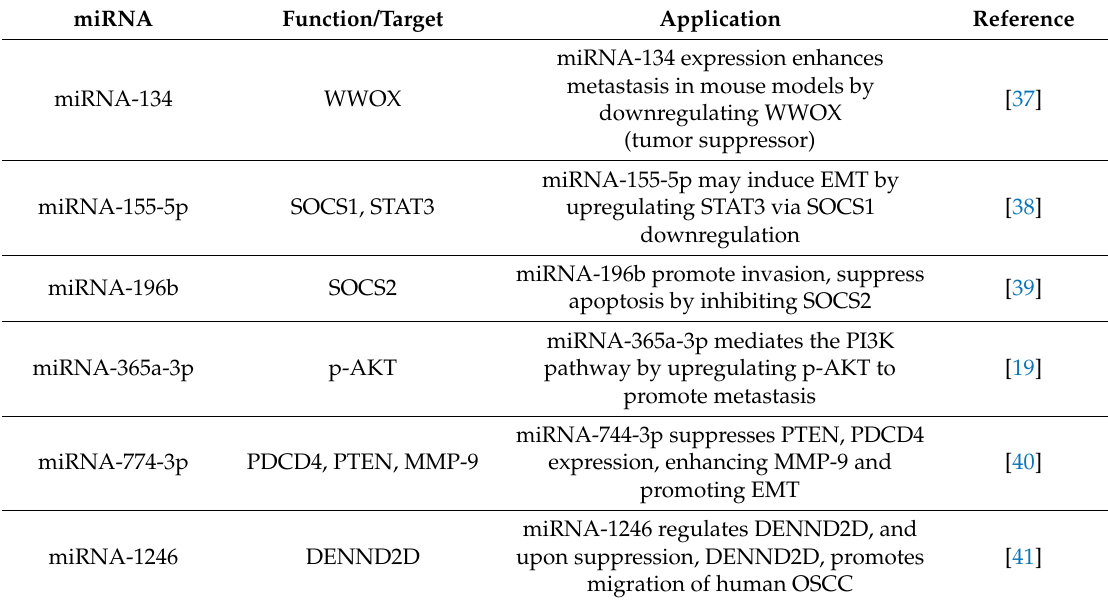
Table 1. miRNAs that promote HNSCC